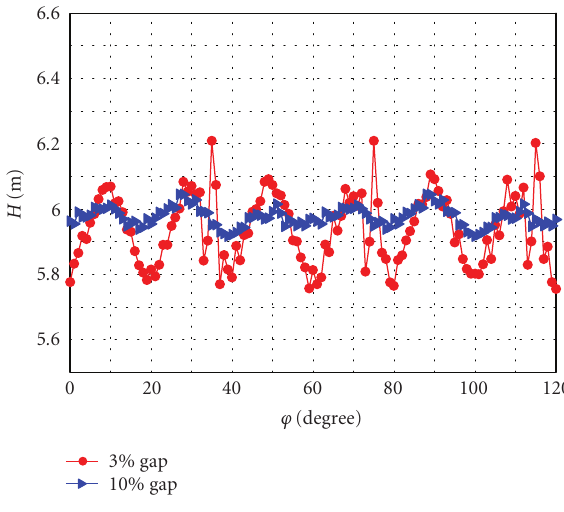
Figure 12: Delivery head